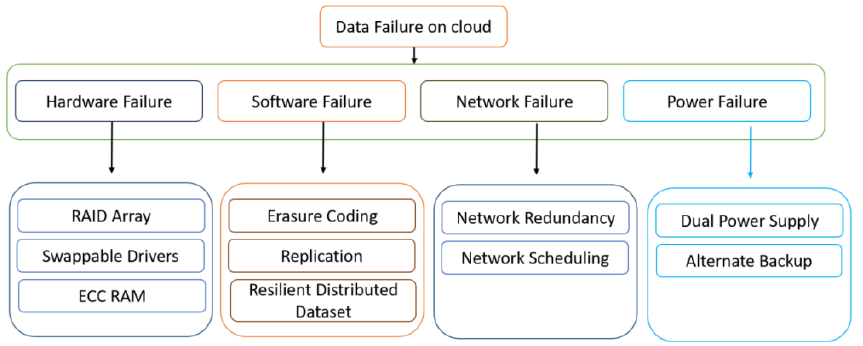
Figure 1. Data Failure in Cloud computing.